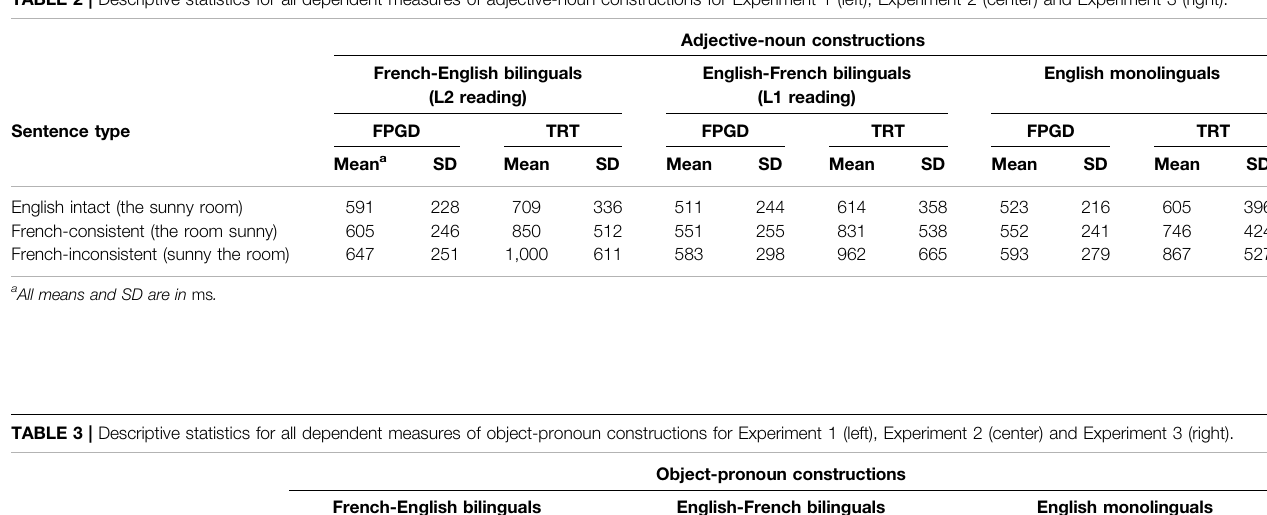
TABLE 2 | Descriptive statistics for all dependent measures of adjective-noun constructions for Experiment 1 (left), Experiment 2 (center) and Experiment 3 (right).